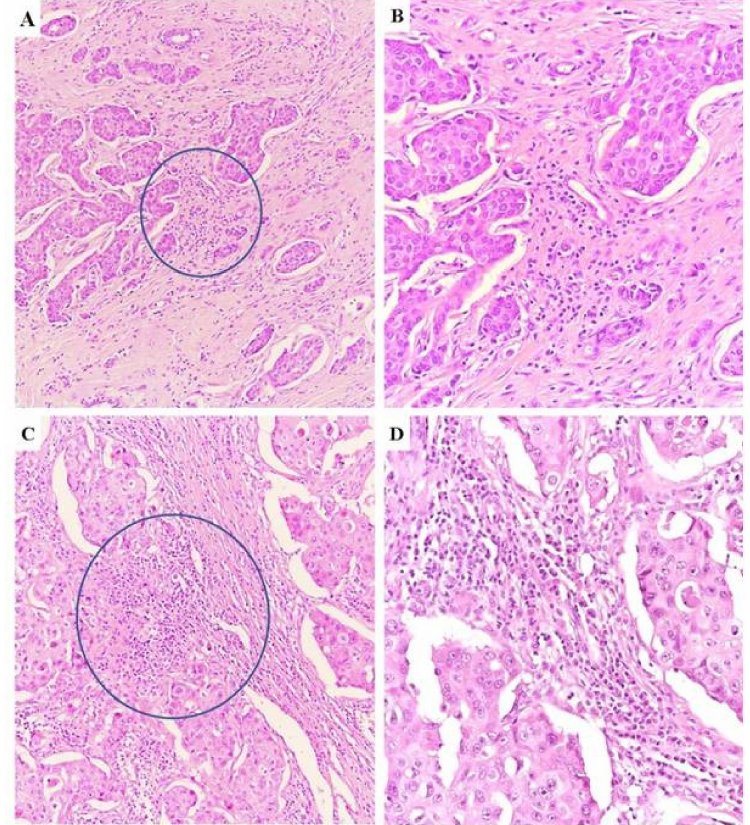
Figure 2. Hematoxylin and eosin (H&E) stained sections illustrating different TILs distribution in our series. ( A ) Invasive breast carcinoma demonstrating low TILs (H&E, × 10). ( B ) Higher magnification of the same case (H&E, × 20) illustrating the TILs distribution in tumor stroma. ( C ) Another invasive breast cancer case categorized as intermediate TILs (H&E, × 10). ( D ) Higher magnification of the same case (H&E, × 20) demonstrating the increased TILs distribution in tumor